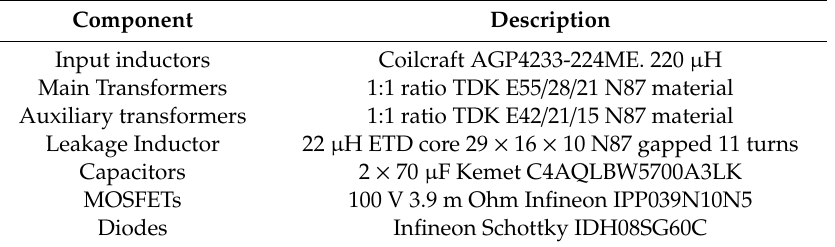
Table 2. Description of